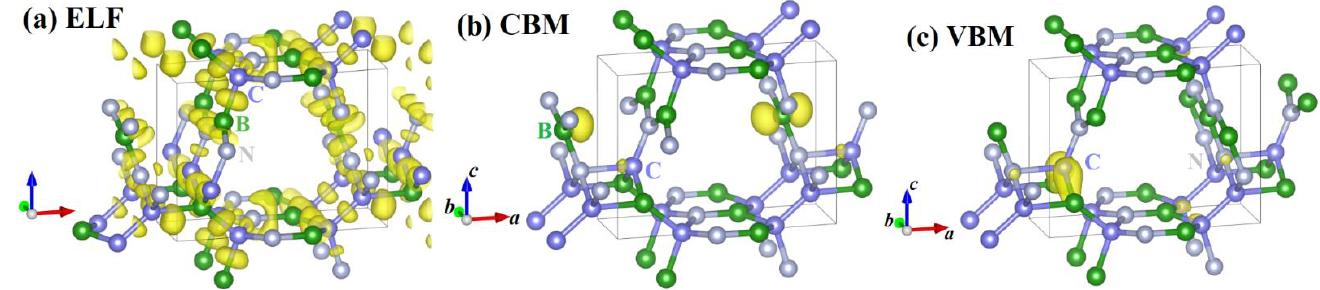
Figure 6. Electronic localization functions ( a ) and band decomposed charge densities of VBM and CBM ( b , c ) of Pm -BCN.